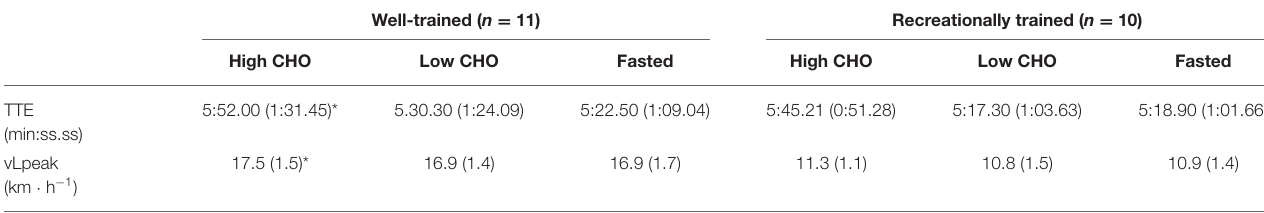
( Table 3 ). No main effect of training status was found for LT2 or OBLA ( p > 0.100); however, WE was lower in the